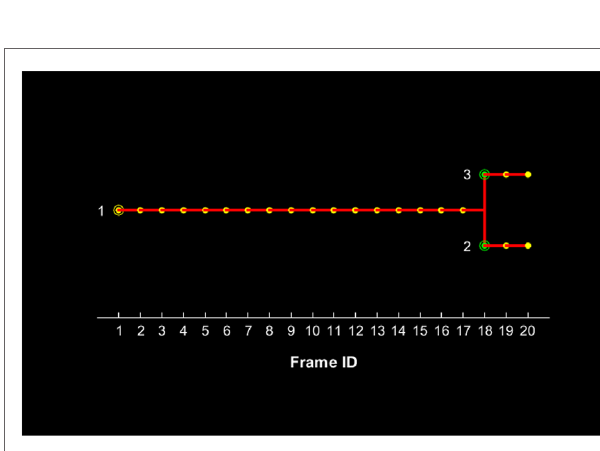
FIGURe 4 | (A) Detailed view of original bright-field image of U251 cells on glass substrate, taken with 40 × objective, with a single (parent) cell detected, indicated by an overlaid yellow–red marker. (B) Detection of two daughter cells post-division. The time difference between the two frames is 50 min.